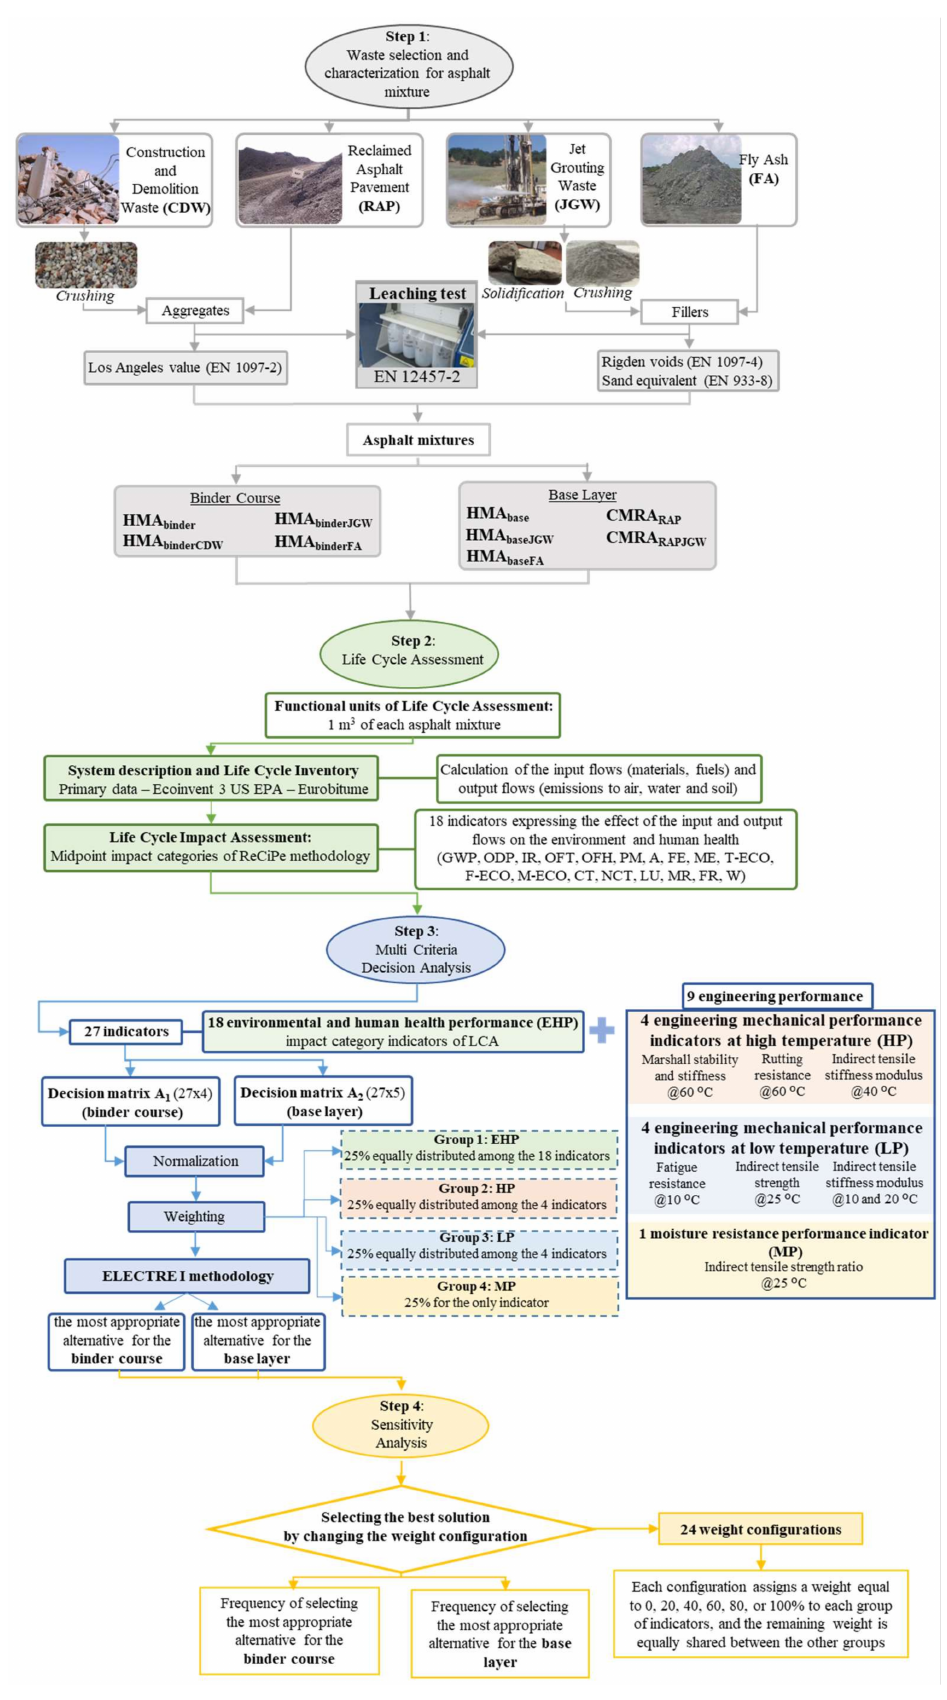
Figure 1. Workflow diagram of the present research